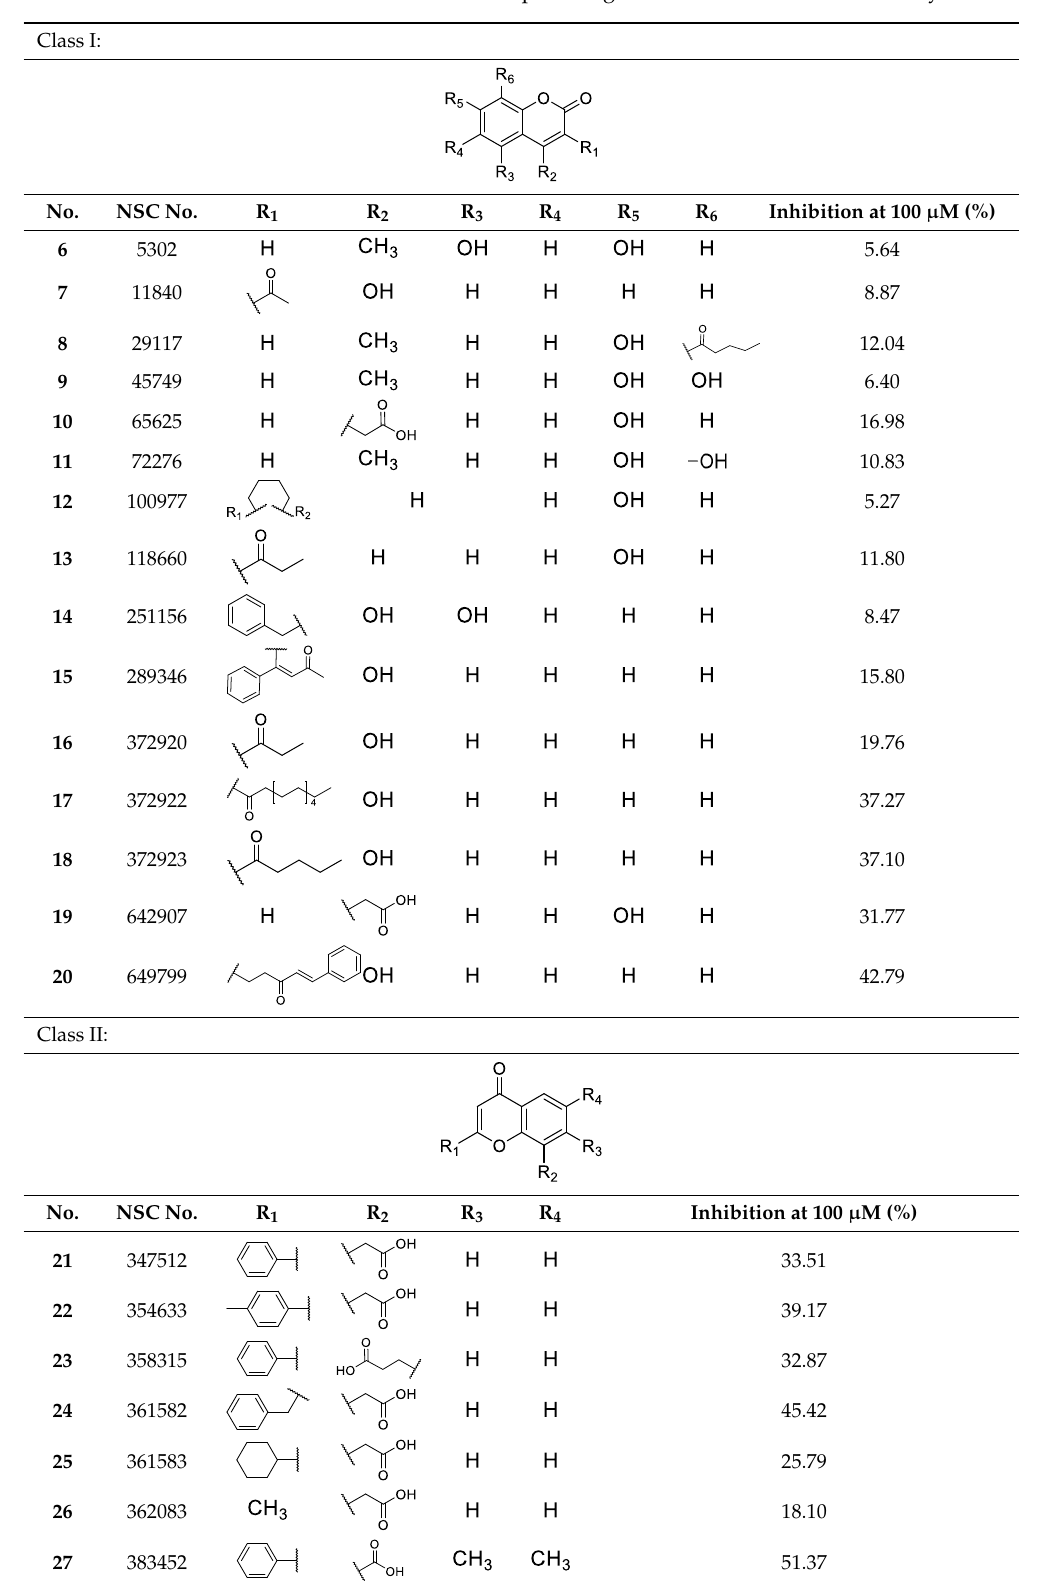
Table 2. The structures and inhibition data of compounds generated from the NCI similarity search.